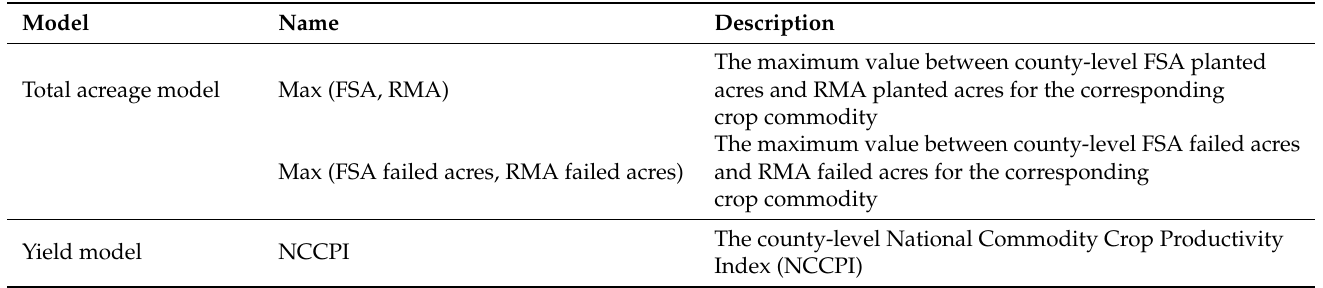
Table A2. The covariate definitions for the crop county estimate models.